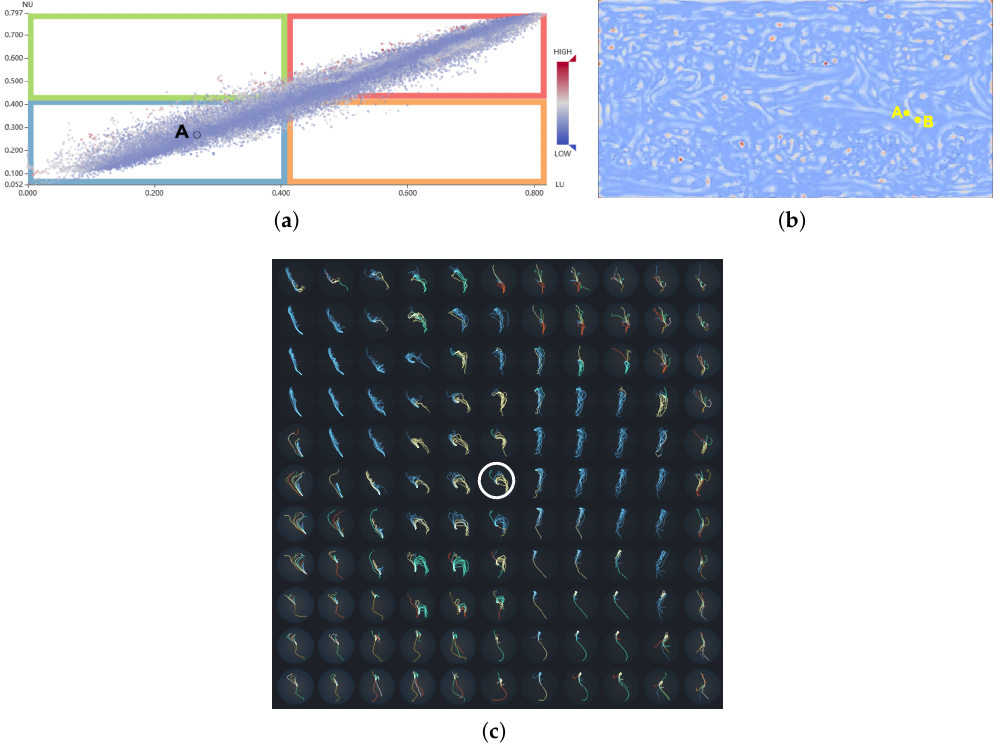
Figure 14. Neighborhood correlation analysis of ECMWF data: ( a ) classification view, ( b ) rendering of CU, and ( c ) comparison view of location